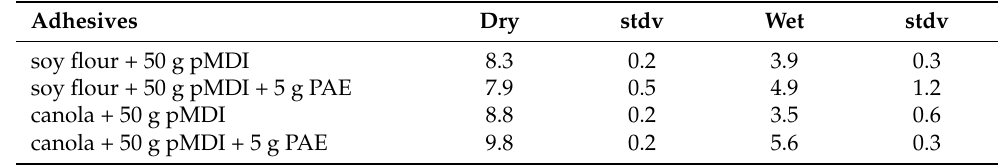
Table 3. ABES shear strength (MPa), dry and wet, of soy or canola adhesives (25% flour solids) with